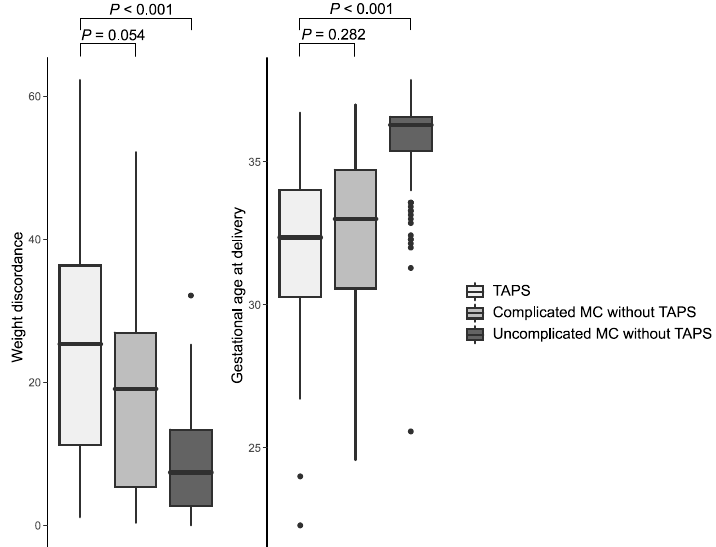
Figure 3. Box plots of gestational age at delivery (weeks) and birth weight discordance (%) in monochorionic diamniotic (MCDA) twins without twin anemia polycythemia sequence (TAPS) and in twins with antenatal diagnosis of TAPS (any criteria). The MCDA twins without TAPS were stratified according to whether they were complicated otherwise (selective fetal growth restriction, twin–twin transfusion syndrome). Fetuses with antenatal diagnosis of TAPS delivered earlier (median: 32.4 vs. 33.0 and 36.3 weeks, TAPS vs. complicated and uncomplicated MCDA, p = 0.282 and p < 0.001, respectively) and had a higher birth weight discordance at birth (25.3% vs. 19.1% and 7.3%, TAPS